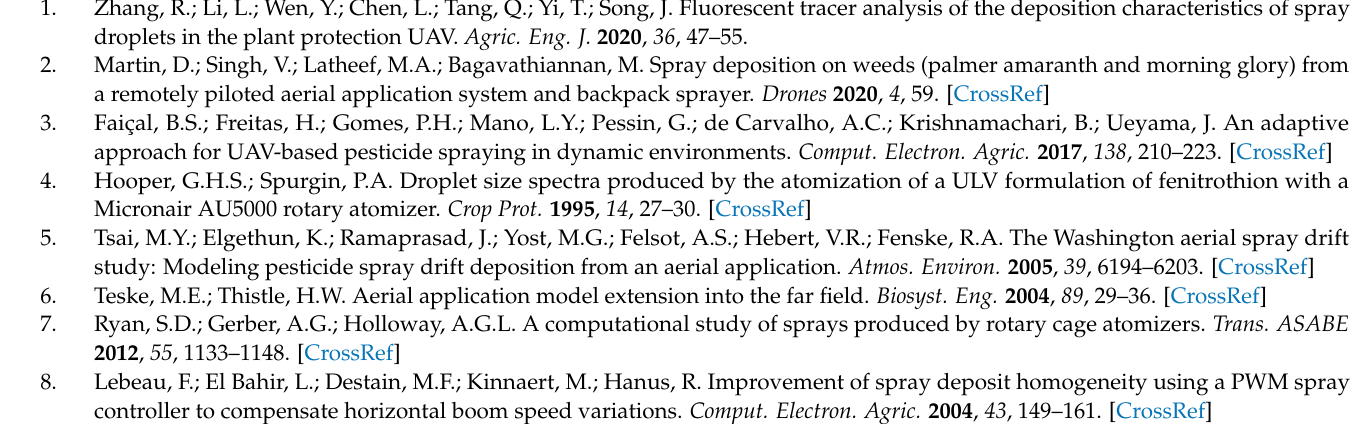
Table S2: Test data for an atomizer with a fan blade angle of 45 ◦ ; Table S3: Test data for an atomizer with a fan blade angle of 55 ◦ ; Table S4: Test data for an atomizer with a fan blade angle of 65 ◦ ; Figure S1: Trend line of droplet size and power at flow rate of 5.0 L/min; Figure S2: Trend line of droplet size and power at flow rate of 10.8